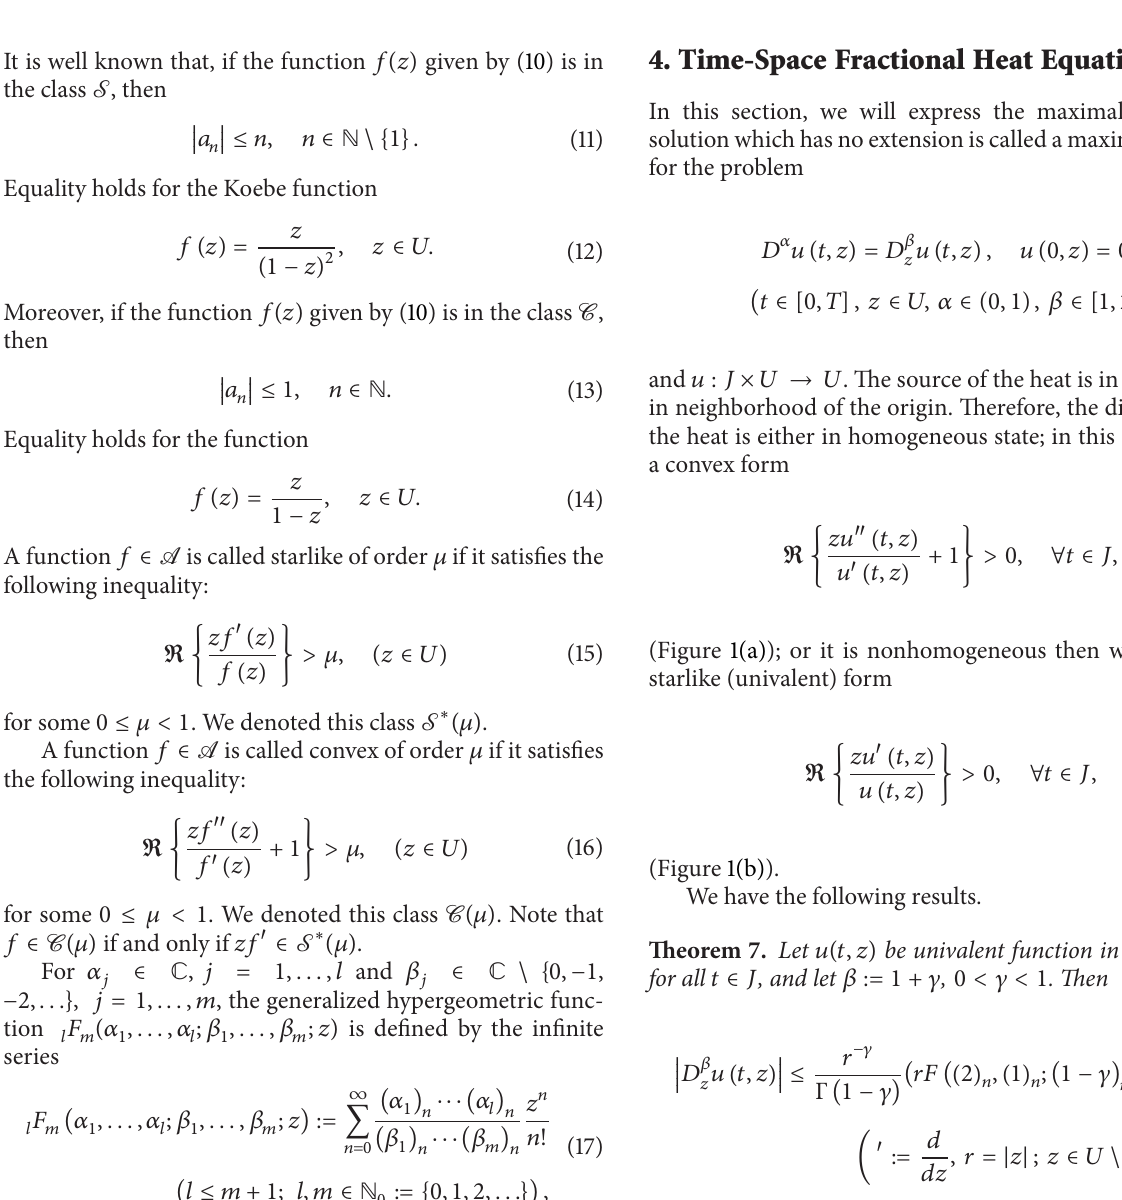
Figure 1: Distributions of the heat in the unit